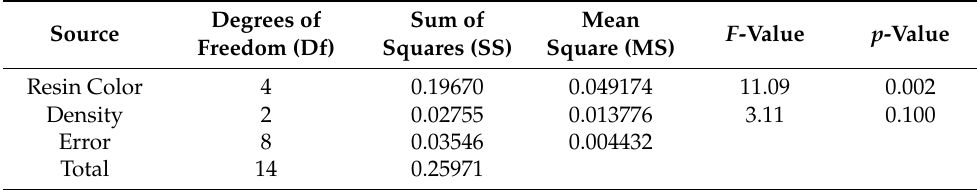
Table 12. Analysis of variance for straightness_Y2.